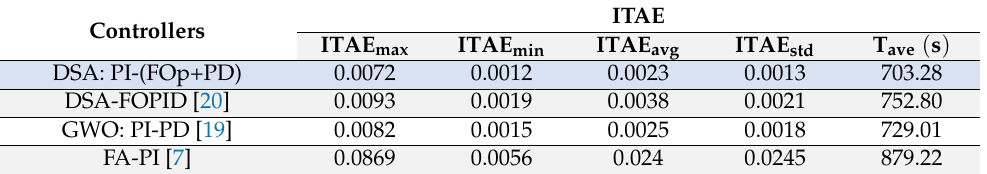
Table 6. Performance analysis of different